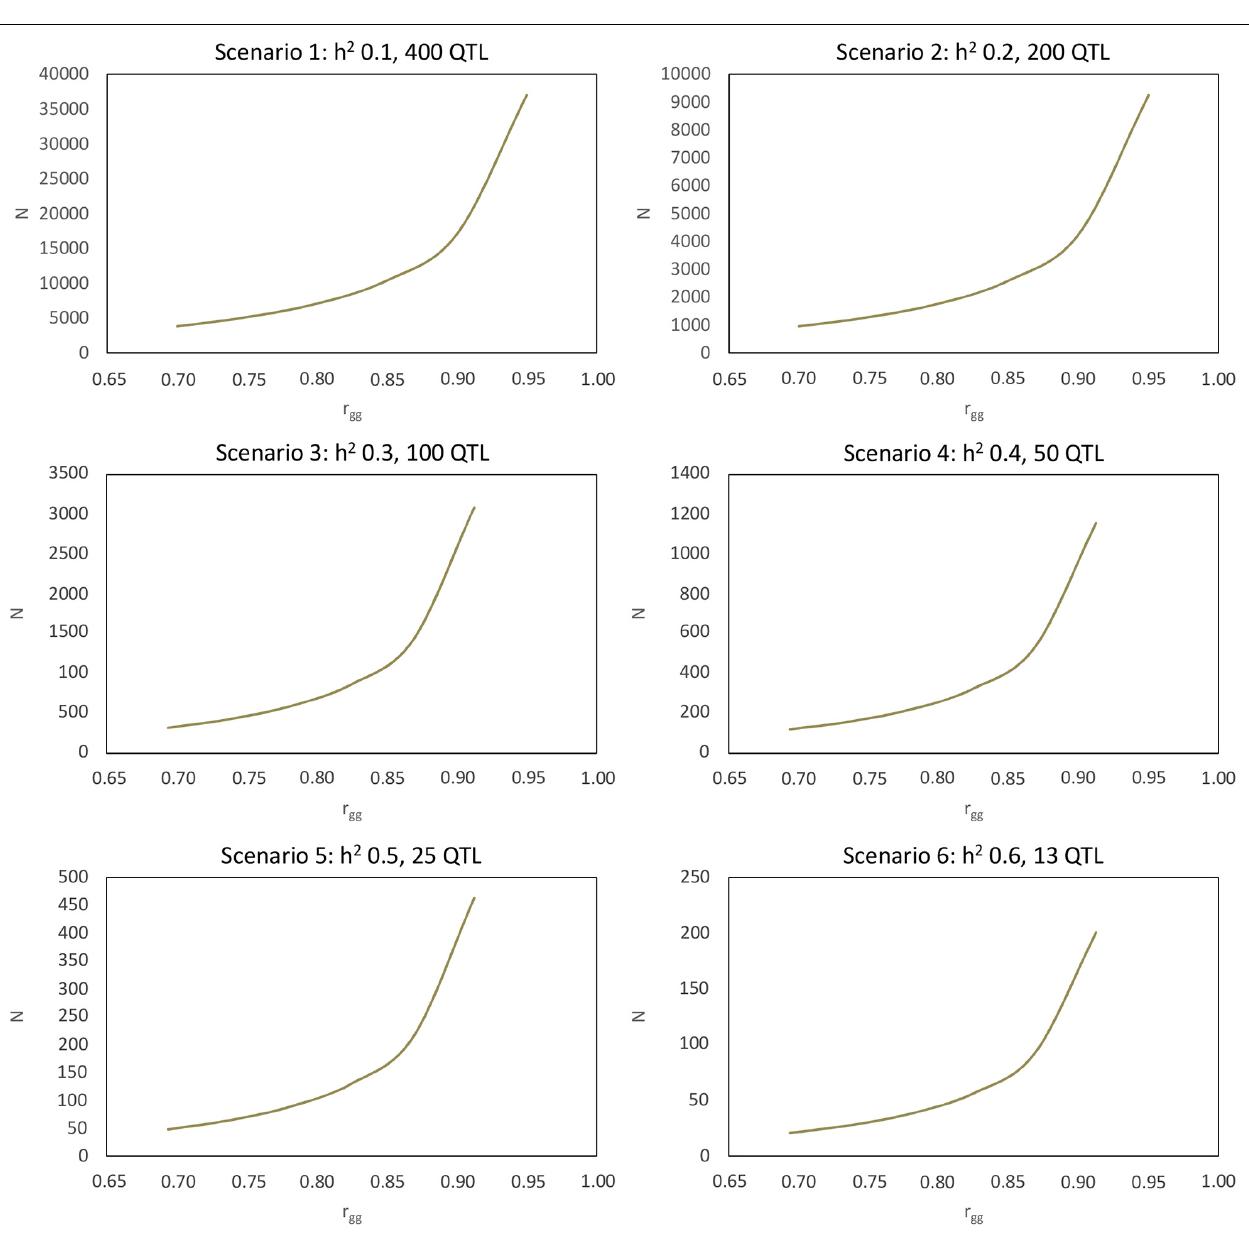
FIGURE 5 | Sample size for genomic selection with desired accuracy ranging from 0.70 to 0.95 in six scenarios in terms of heritability and quantitative trait locus (QTL)